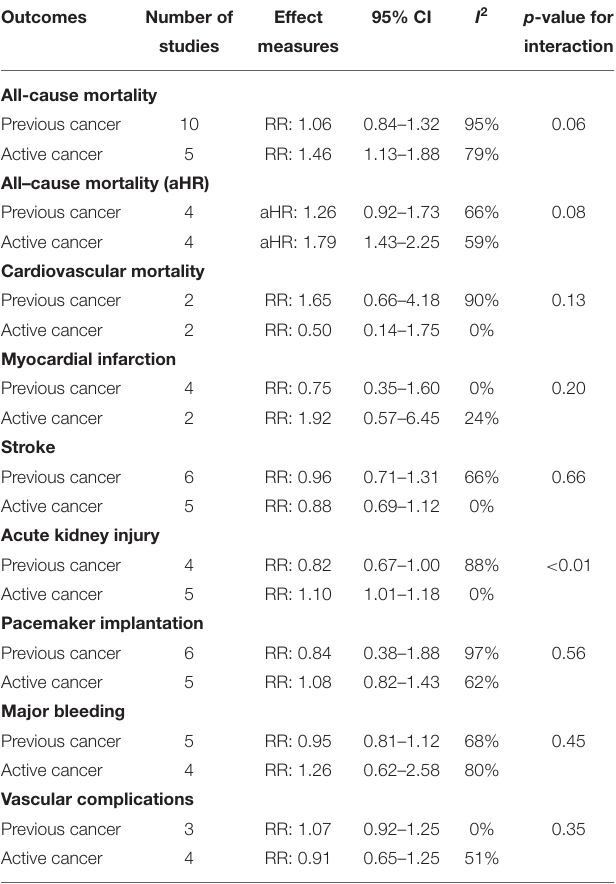
88%), compared to patients without cancer ( Table 2 ). The test